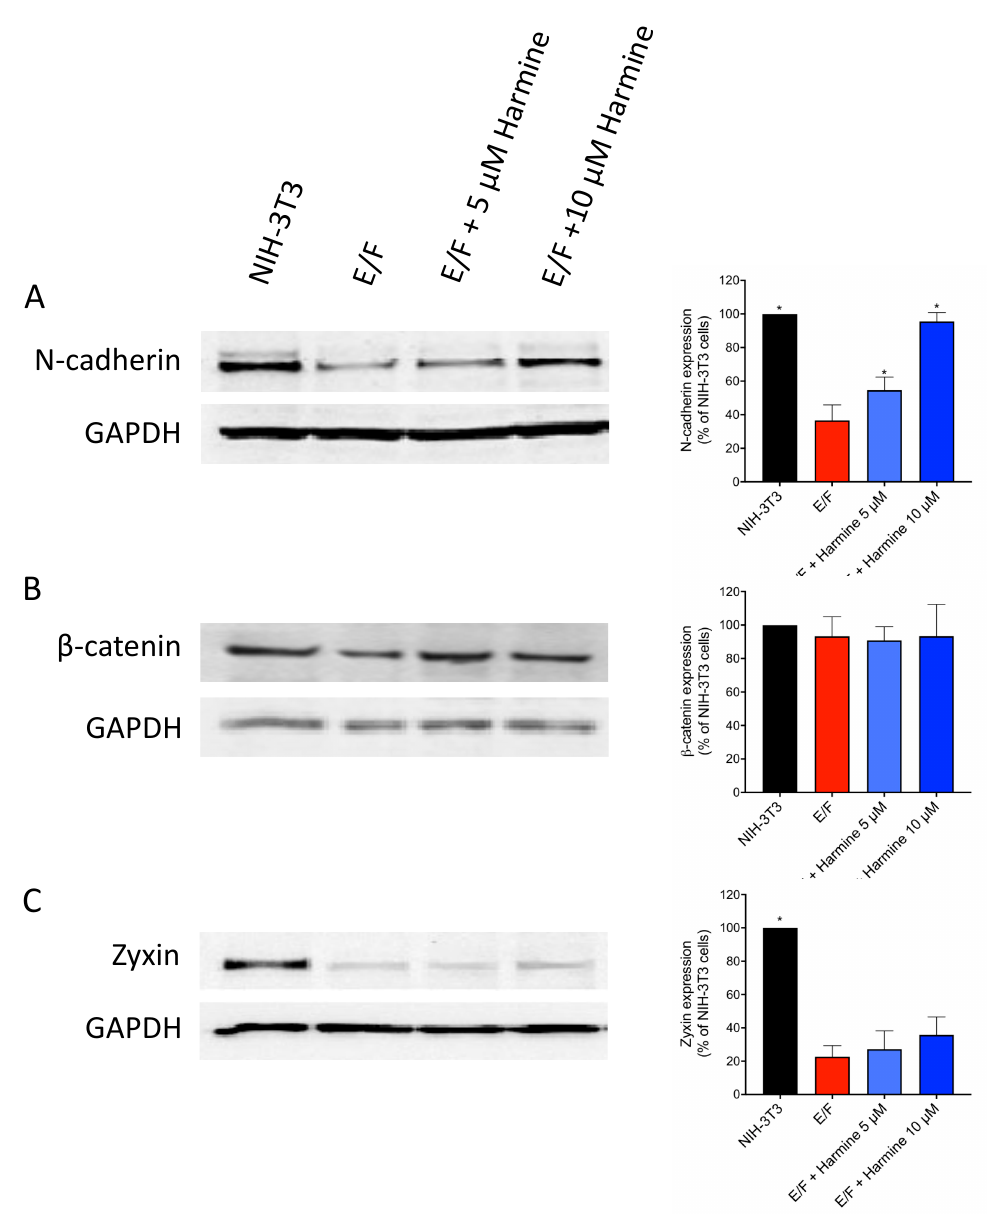
Figure 3. Effect of harmine on the expression of the cell-adhesion-related proteins. NIH-3T3 and E/F cells were cultured in the absence or presence of 5 µM or 10 µM harmine, as indicated. After 72 h of culture, the cells were lysed and proteins analyzed by Western blot using anti-N-cadherin ( A ), anti- β -catenin ( B ), anti-zyxin ( C ) and anti-GAPDH ( A – C ) antibodies. The autoradiograms presented are those of a typical experiment. The histograms represent a quantitative analysis of protein expression normalized to NIH-3T3 control cells. The results presented are the means ± SEM for two independent experiments. * p < 0.05 versus control untreated E/F cells.